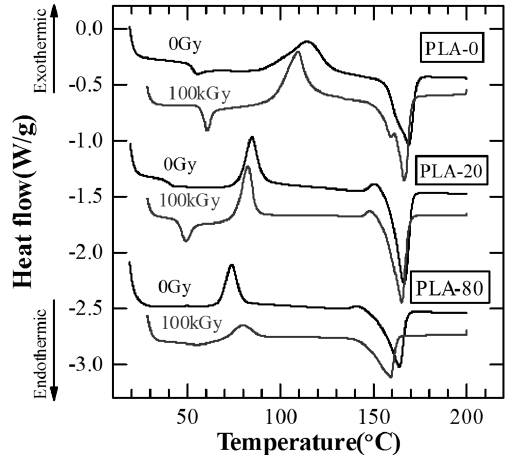
Figure 7. DSC curves for irradiated PLA. Table 2. T g , T c and T m obtained from the Figure 7.